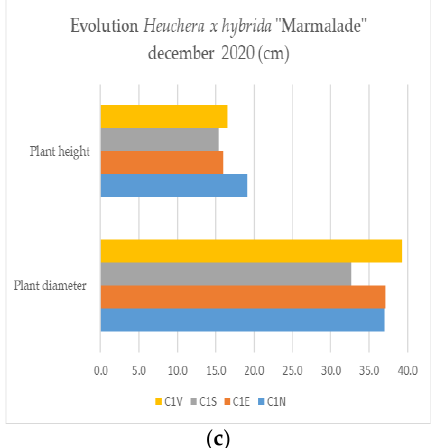
Figure 14. The evolution of height and diameter Heuchera x hybrida ‘Marmalade’, May–December 2020 on cardinal orientations: ( a ) May; ( b ) August; and ( c ) December. The highest average values, in terms of the number of leaves, was obtained on the eastern facade in May, August, and December (Figure 15).